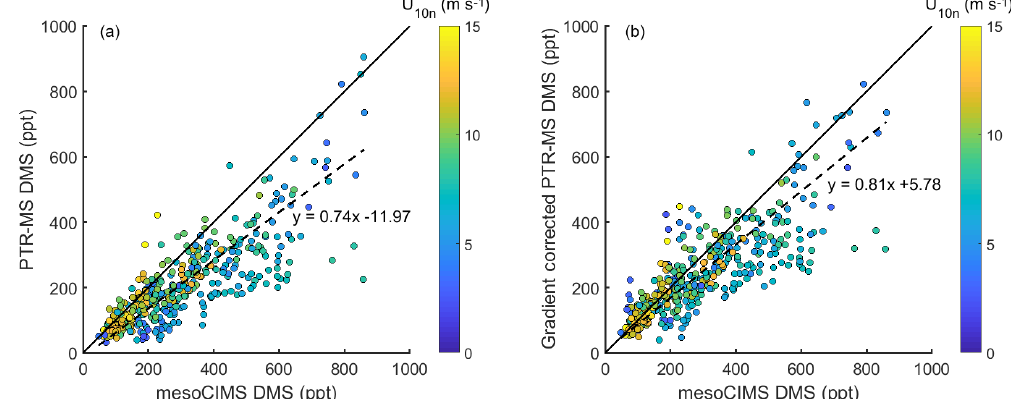
Figure 2. (a) DMS a measured by mesoCIMS ( x axis) and PTR-MS ( y axis) (b) mesoCIMS ( x axis) and PTR-MS ( y axis) DMS data corrected for the expected concentration gradient (observed PTR-MS DMS + calculated delta DMS). Dashed lines represent the reduced major axis regression and solid lines represent a 1:1 relationship.